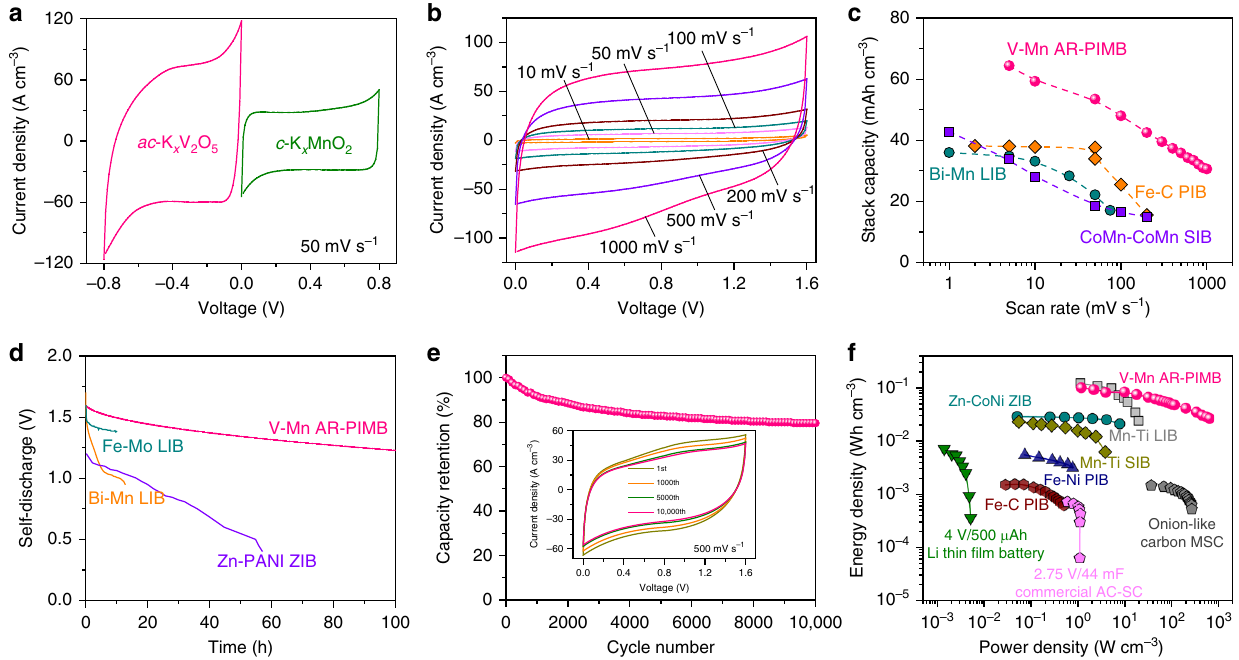
Fig. 4 Electrochemical performance of V-Mn AR-PIMBs. a Representative CV curves for single electrode of K x V 2 O 5 ( x = 0.25) anode and K x MnO 2 ( x = 0.23) cathode supported by nanoporous gold current collector in the voltage window of − 0.8 to 0 and 0 – 0.8 V at a scan rate of 50 mV s − 1 in 0.5 M K 2 SO 4 . b CV curves at various scan rates for aqueous V-Mn AR-PIMBs that are constructed with K x V 2 O 5 and K x MnO 2 on nanoporous gold current collectors as anode and cathode. Voltage window is extended to 1.6 V in aqueous electrolyte of 0.5 M K 2 SO 4 . c Stack capacity of aqueous V-Mn AR-PIMBs at various scan rates, comparing with previously reported rechargeable aqueous alkaline-metal-ion batteries, such as K + -ion batteries with carbon-encapsulated Fe 3 O 4 nanorod array anode and carbon nanotube fi lm cathode in 3 M KOH electrolyte (Fe – C PIBs) 56 , Li + -ion batteries with Bi 2 O 3 anode, and LiMn 2 O 4 cathode in a mixed electrolyte of Li 2 SO 4 and LiCl (Bi – Mn LIBs) 57 , and symmetric Na + -ion batteries of biphase cobalt – manganese oxide nanosheets in 0.1 M Na 2 SO 4 (CoMn – CoMn SIBs) 21 . d Comparison of self-discharge performance for aqueous V-Mn AR-PIMBs with aqueous Bi – Mn LIBs 57 , LiFePO 4 //Mo 6 S 8 (Fe – Mo) LIB, and Zn//polyaniline Zn 2 + -ion battery (Zn – PANI ZIB) 58 . e Cycling stability of aqueous V-Mn K + -ion microbatteries at the scan rate of 500 mV s − 1 . Inset: Typical CV curves at different cycles. f Ragone plot comparing stack energy and power densities of V-Mn AR-PIMB with commercially available 4 V/500 μ Ah Li thin- fi lm battery, 2.75V/44 mF commercial activated carbon supercapacitors (AC-SC) 9,14 , Fe – C PIB 56 , carbon fi ber supported Fe 3 O 4 //NiO (Fe – Ni) PIB, Na 0.44 MnO 2 //NaTi 2 (PO 4 ) 3 (Mn – Ti) SIB 28 , Li 1.1 Mn 2 O 4 //LiTi 2 (PO 4 ) 3 (Mn – Ti) LIB and CoNi(OH) 2 //Zn (CoNi-Zn) ZIB 59 , as